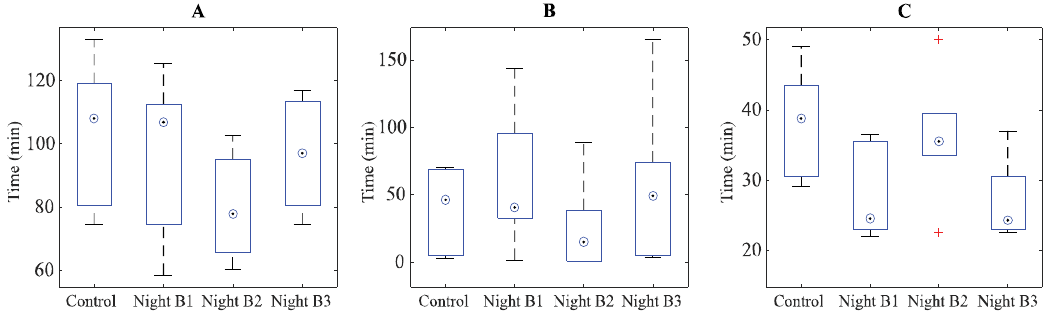
Figure 2. Median ( ◉ ), interquartile range (boxes) and maximum/minimum values (whiskers) for objective sleep parameters from Study B. ( A ). Total time in N3. ( B ). Time between sleep onset and first awakening. ( C ). Maximum continuous time in N2 sleep.